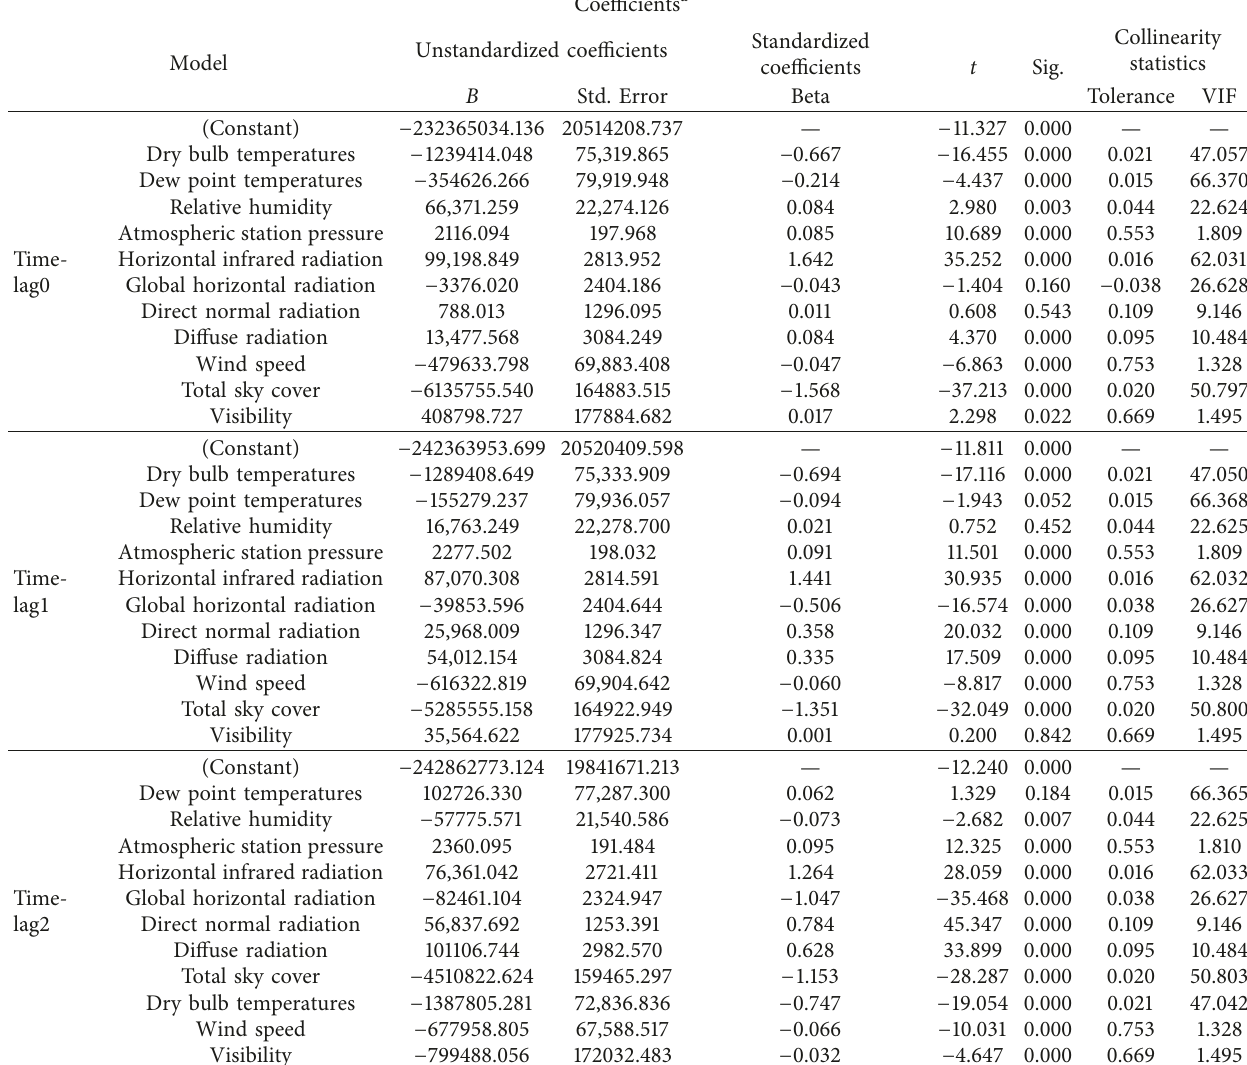
Table 12: Model summary for a DOE medium office building depending on